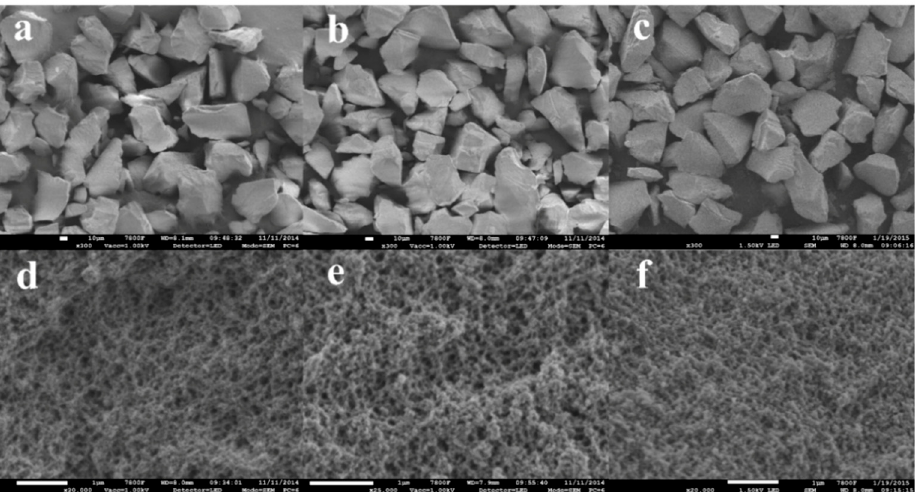
Figure 1. Scanning electron microscopy (SEM) images for phenolphthalein (PP)-imprinted polymer (PPMIP) ( a , scale length: 10 µ m; d , scale length: 1 µ m), bisphenol A (BPA) imprinted polymer (BPAMIP) ( b , scale length: 10 µ m; e , scale length: 1 µ m) and non-imprinted polymer (NIP) ( c , scale length: 10 µ m; f , scale length: 1 µ m).